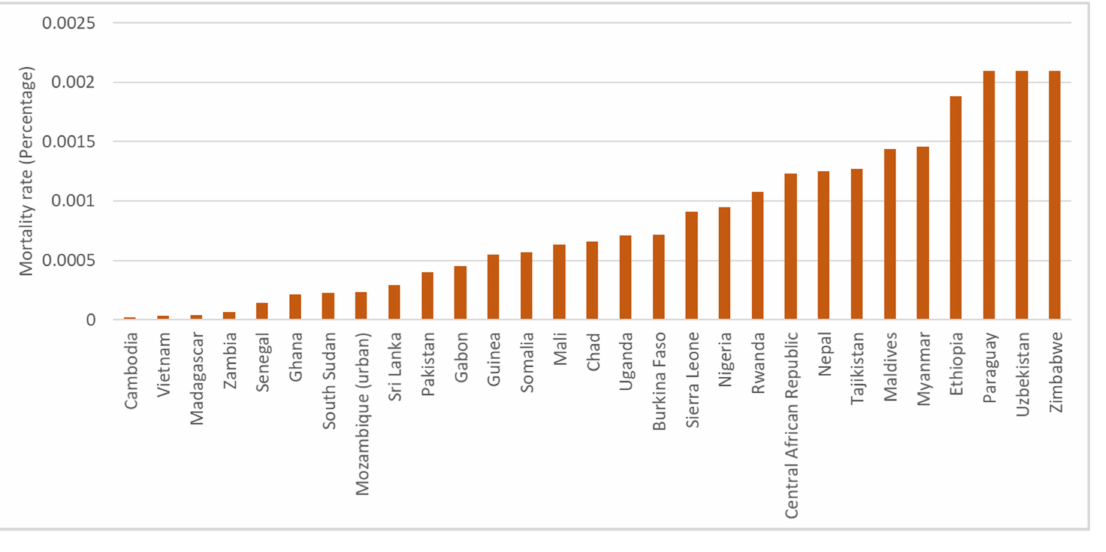
Figure 3. A total of 29 countries’ mortality rates of the COVID-19 epidemic that were lower than the median of the whole